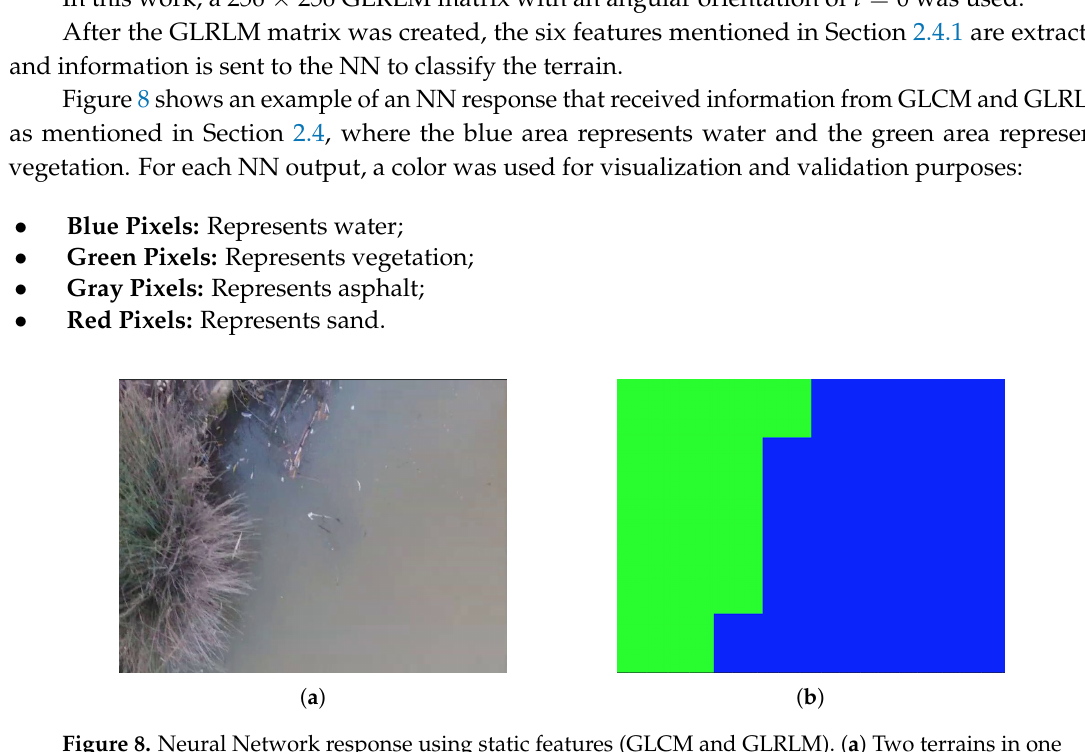
Figure 8. Neural Network response using static features (GLCM and GLRLM). ( a ) Two terrains in one frame (vegetation and water); ( b ) NN results (green is vegetation and blue is